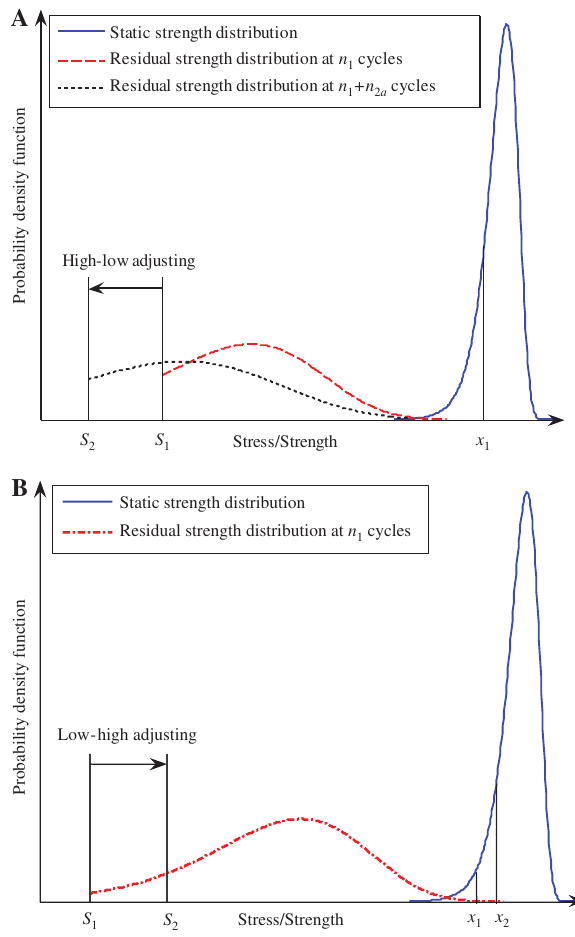
Figure 2 Residual strength distribution of composites under load- ing adjustment: (A) high-low case; (B) low-high